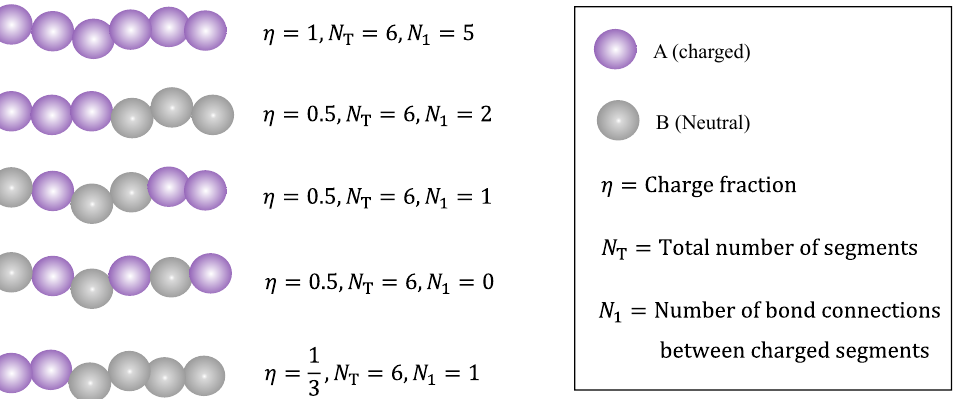
Figure 2. Examples illustrating how the charge fraction η and sequence distribution (from top to bottom: fully charged, block copolymer, random copolymer, alternating copolymer, and block copolymer) affect the relationship between the number of bond connections among charged beads and the total number of chain